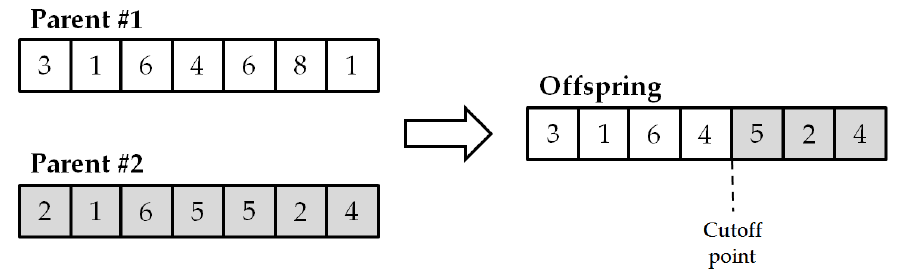
Figure 2. One-point crossover operator